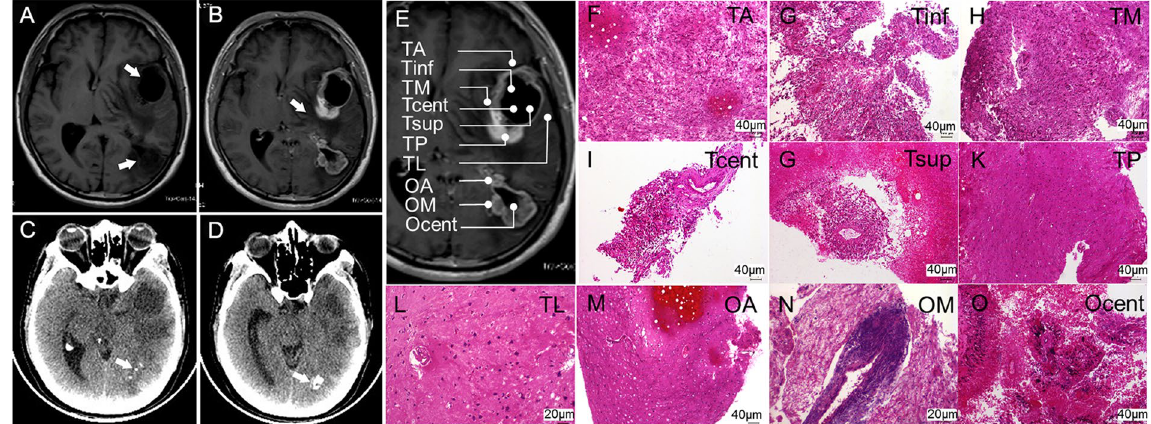
Figure 2. Clinical imaging and morphological features of the tumors (biopsies) of Patient 1. Two low-signal- intensity areas in the left temporal and occipital lobes and the ring-like peripheral edema are shown in non- enhanced ( A ) and corresponding enhanced T1-weighted MRI images ( B ). The lesions and edema are indicated by arrows. Calcification (indicated by arrows) was apparent in the occipital lesion under non-enhanced CT ( C and D ). ( E ) The sites of ten biopsies harvested from the surgical resection specimen are represented schematically on the MRI image. ( F – O ) Histologic specimens of the ten tumor samples stained with